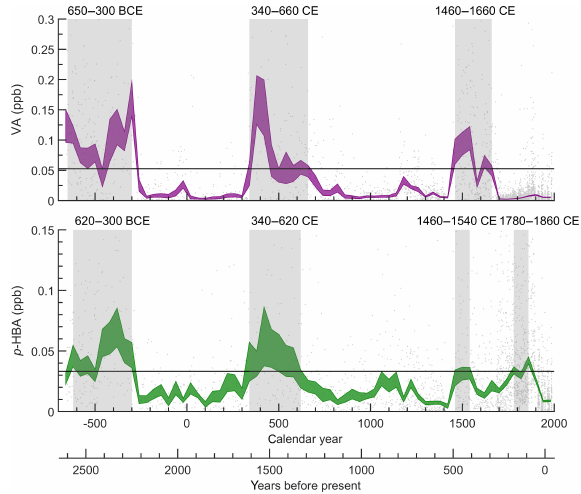
Figure 4. Akademii Nauk vanillic acid (top) and para - hydroxybenzoic acid (bottom) ice core records. Individual measure- ments are shown as gray dots. The color-filled lines are exponentials of ± 1 standard errors of 40-year bin averages of the log-transformed data. The solid horizontal lines represent the 75th percentile of each dataset. The vertical gray shaded areas are periods of elevated vanil- lic acid or para -hydroxybenzoic acid, identified as periods when the bin-averaged data are in the upper quartile of the transformed